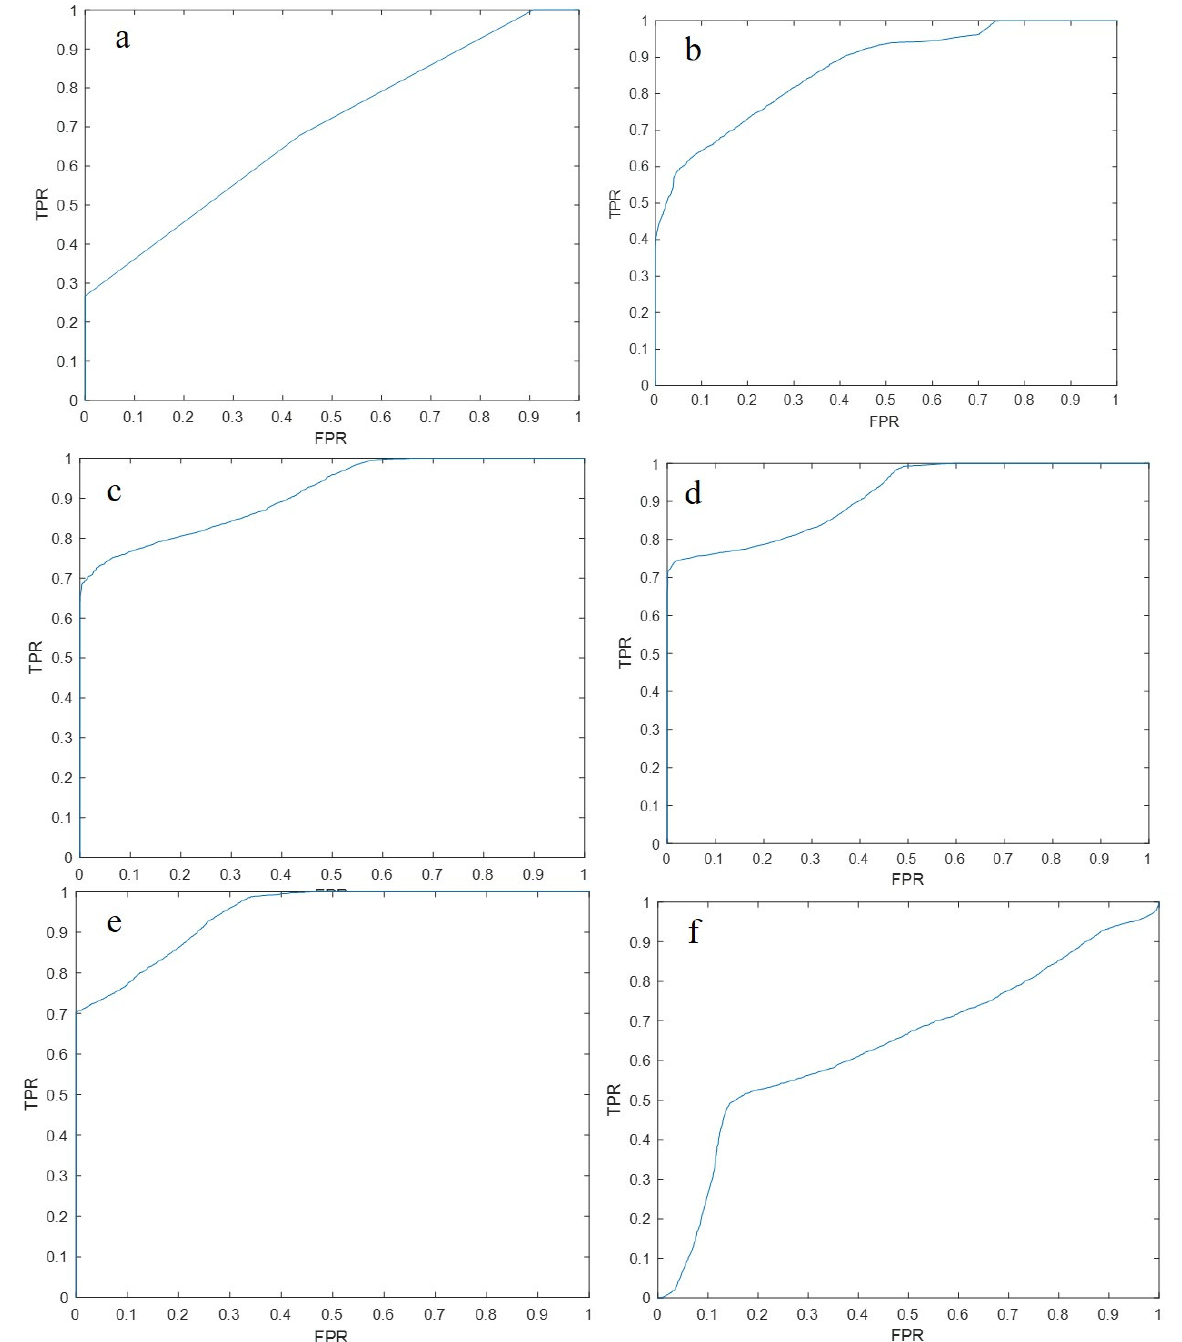
Figure 6. The ROC curve of epilepsy classification using the SVM classifier using microstate parameters as feature inputs, plotted with recall as same as the true positive rate (TPR) on the y-axis, and specificity as the same as the false positive rate (FPR) on the x-axis. ( a ) The ROC curve of the EEG microstate parameters in the delta (0.5~4 Hz) frequency band using the SVM classifier; ( b ) The EEG microstate parameters in the θ (4~8 Hz) frequency band using SVM. The ROC curve of the classifier classification; ( c ) The ROC curve of the α (8~13 Hz) frequency band EEG microstate parameters using the SVM classifier; ( d ) The β (13~30 Hz) curve. The ROC curve of the EEG microstate parameters of the frequency band classified by the SVM classifier; ( e ) The ROC curve of the EEG microstate parameters of the γ (30~45 Hz) frequency band classified by the SVM classifier; ( f ) The ROC curve of the EEG microstate parameters in the 45~80 Hz frequency band using the SVM classifier.